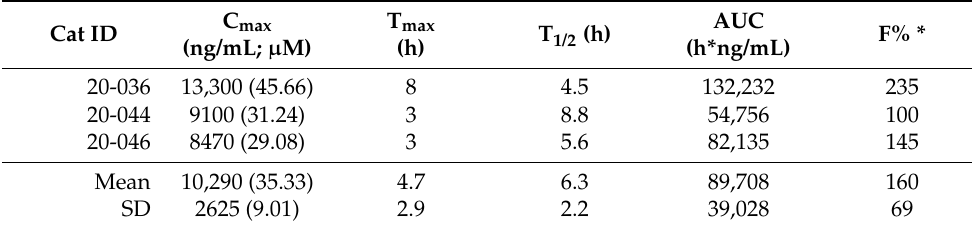
Figure 4. Detection of the metabolite, GS-441524, in the plasma of cats administered either oral GS-441524 (25 mg/kg, red line), oral RDV (25 mg/kg, solid black line), or intravenous RDV (7 mg/kg, dashed black line) over 24 h. Data are shown as the mean ± SD (N = 3) per drug cohort. Table 3. Pharmacokinetic parameters for GS-441524 after a single oral dose of GS-441524 (25 mg/kg) in 3 cats.